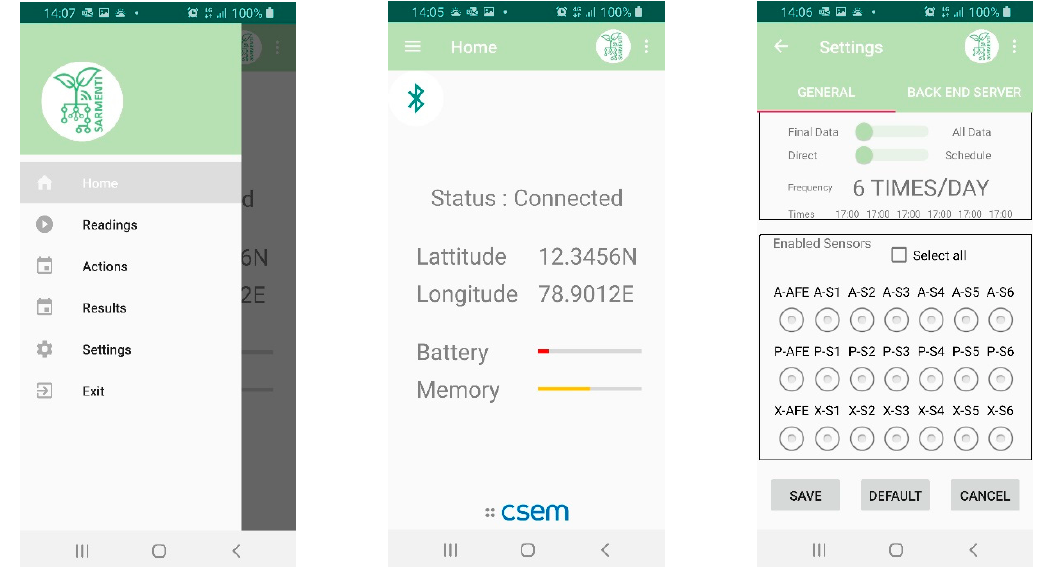
Figure 15 . Some of the Mobile Application screens . Figure 15. Some of the Mobile Application screens.